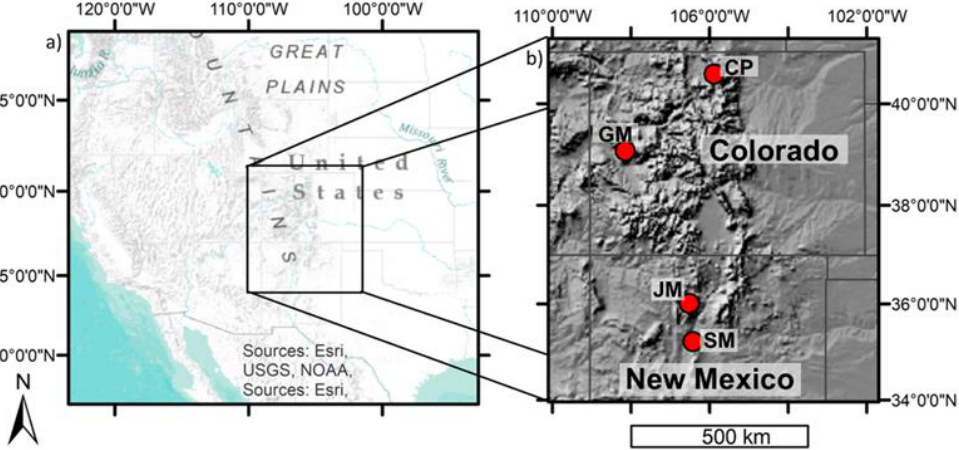
Figure 2. Site locations for Cameron Pass, CO (CP); Grand Mesa, CO (GM); Jemez Mountains, NM (JM); and Sandia Mountains, NM (SM) displaying ( a ) the relative location in the western U.S. and ( b ) a hillshade terrain map of Colorado and New Mexico.